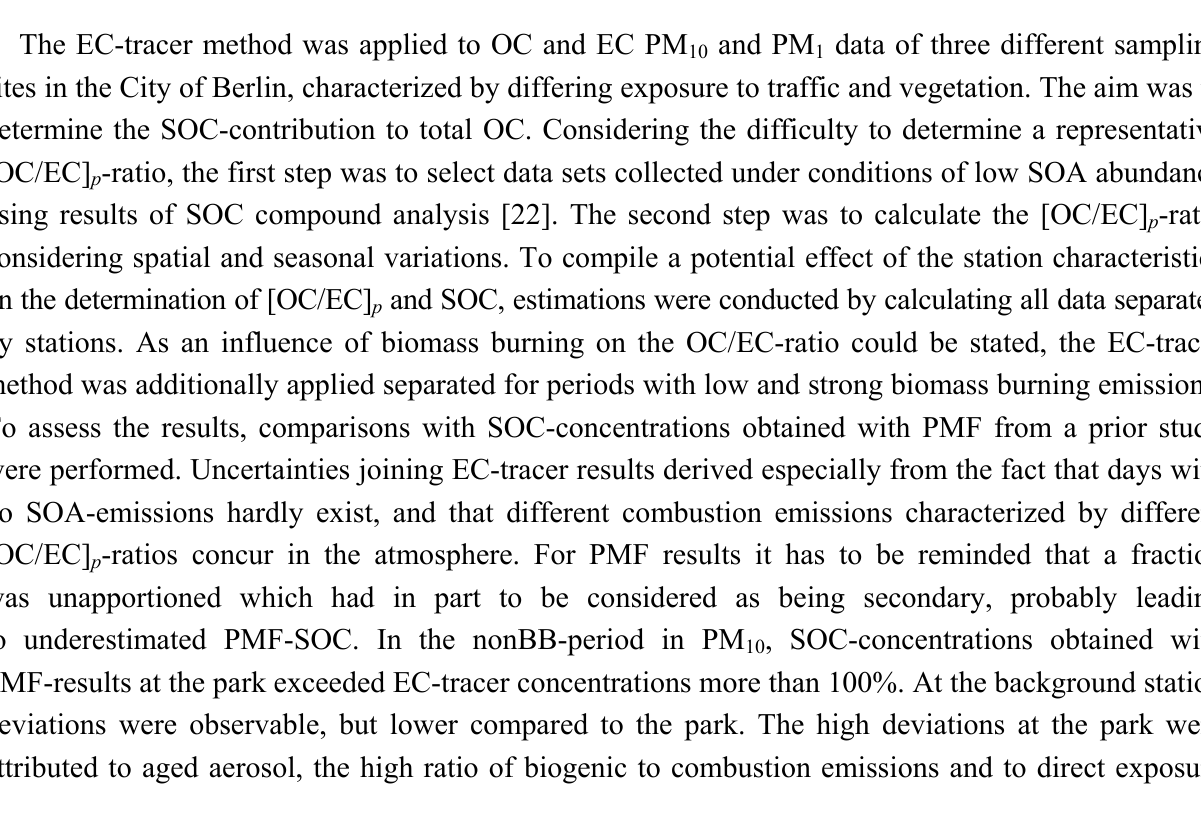
) for the HV and regV sites, separated by bio